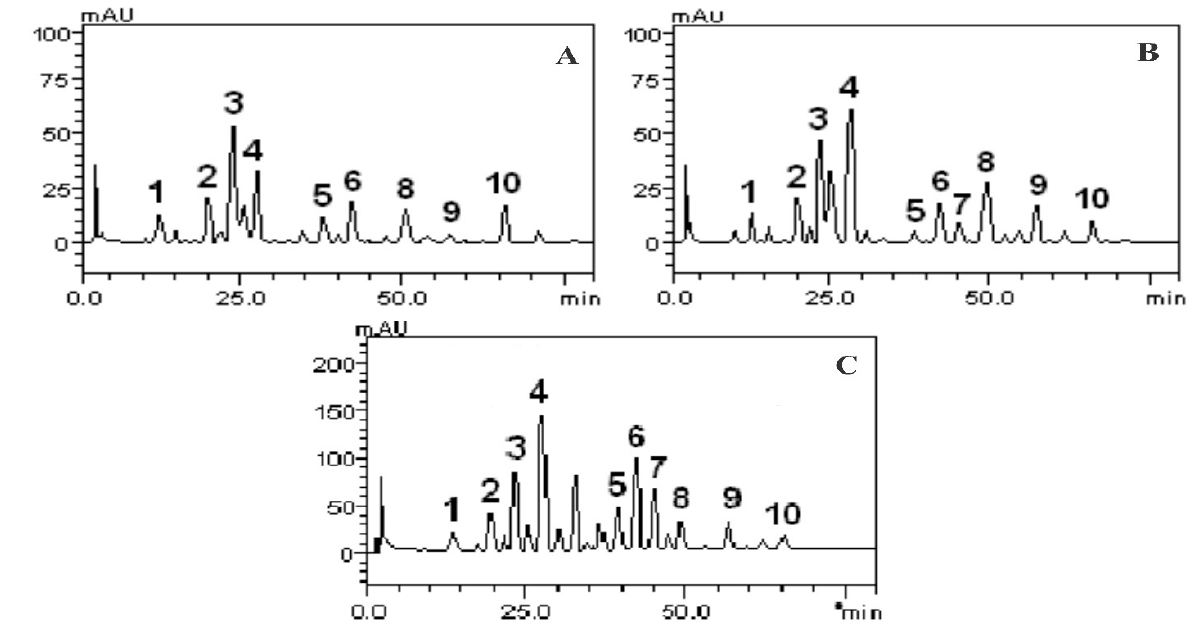
Figure 1. Elution profiles of HPLC/DAD of EELPa ( A ), EELPb ( B ) and EELPo ( C ). Gallic acid (peak 1), catechin (peak 2), chlorogenic acid (peak 3), caffeic acid (peak 4), rutin (peak 5), quercitrin (peak 6),isoquercitrin (peak 7), quercetin (peak 8), kaempferol (peak 9), kaempferol glycoside (peak 10). Calibration curve for gallic acid: Y = 16,479x + 1236.5 (r = 0.9991); catechin: Y = 11,355x + 1047.1 (r = 0.9987); chlorogenic acid: Y = 17,035x + 1304.6 (r = 0.9997); caffeic acid: Y = 13,674x + 1288.4 (r = 0.9989); rutin: Y = 14,756x + 1258.7 (r = 0.9999), quercetin: Y = 15,071x + 1241.6 (r = 0.9985), isoquercitrin: Y= 12,873x + 1325,6 (r = 0.9998); quercitrin: Y = 11,870x + 1329,8 (r = 0.9993) and kaempferol: Y = 12,953x + 1063.2 (r = 0.9997).